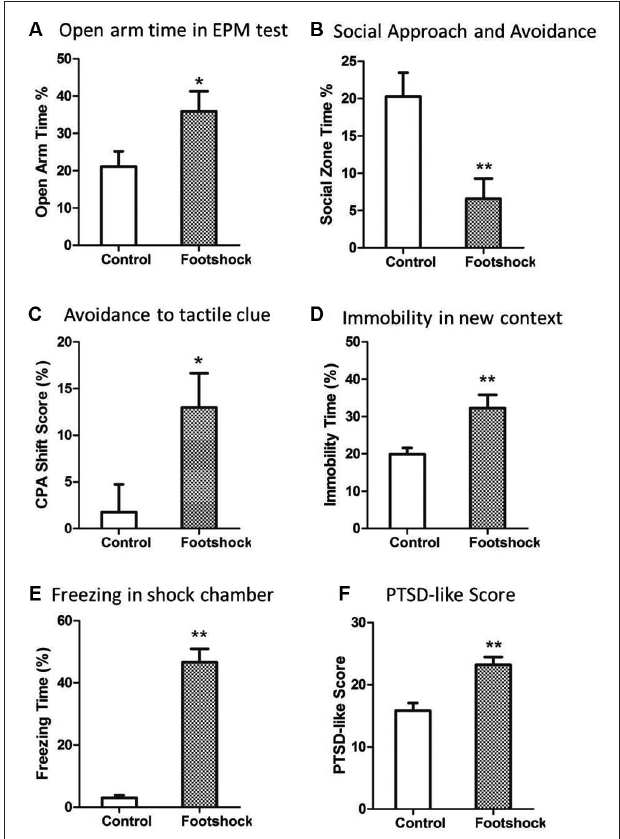
FIGURE 2 | Intense footshocks induced significant PTSD-like behaviors. (A) Open arm time in EPM test; (B) Social zone time in social approach and avoidance test; (C) Conditioned place avoidance to shock tactile clue; (D) Immobility time percent in a new context; (E) Freezing time percent in shock chamber after re-exposure to shock context; (F) PTSD-like symptom score (average of five tests rank scores). * p < 0.05, ** p <